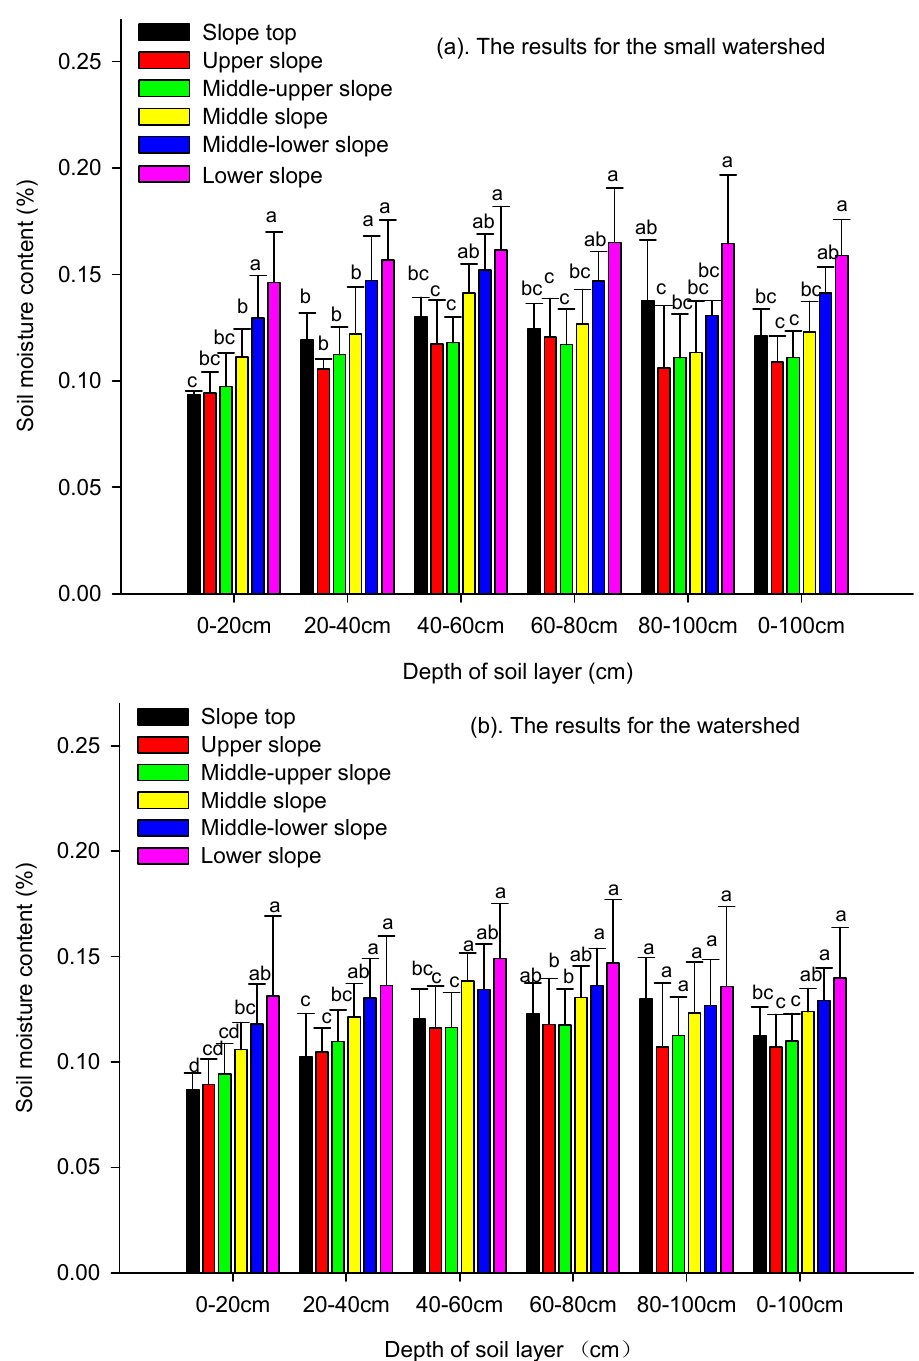
Figure 3. Differences in soil moisture value at different locations on the hill